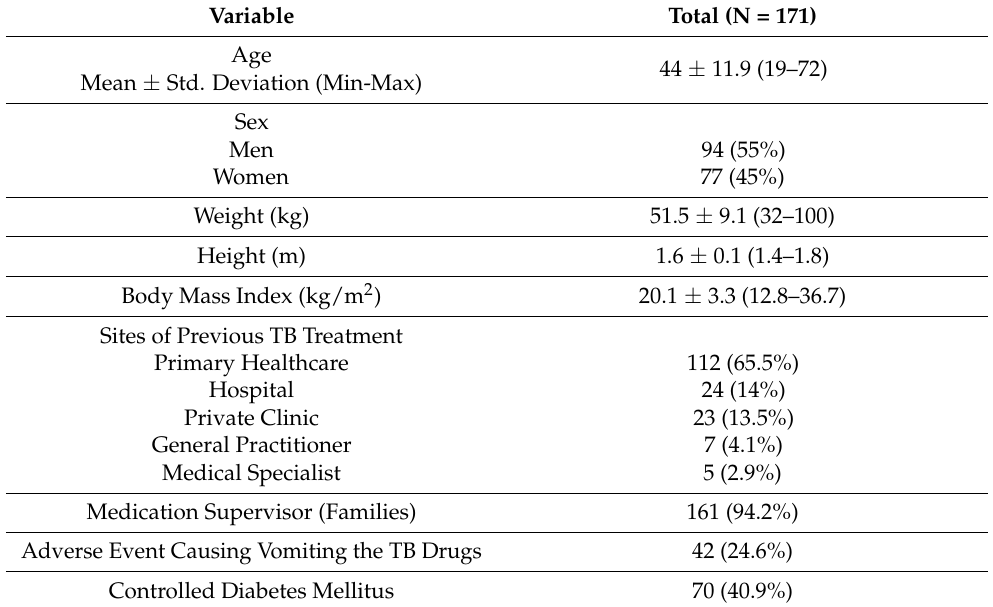
Table 1. Characeristic of Drug-Resistant Tuberculosis Patients from Cases of Treatment Failure with First Line Regimens.